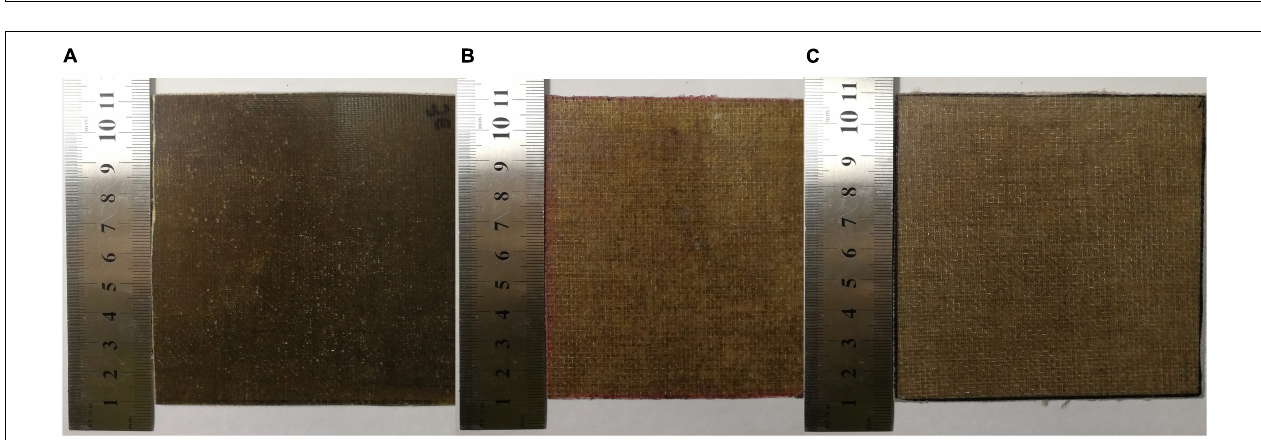
FIGURE 2 | (A) Engineering drawing design of the thermography system in a close apparatus. (B) Rear side and front view of the apparatus.